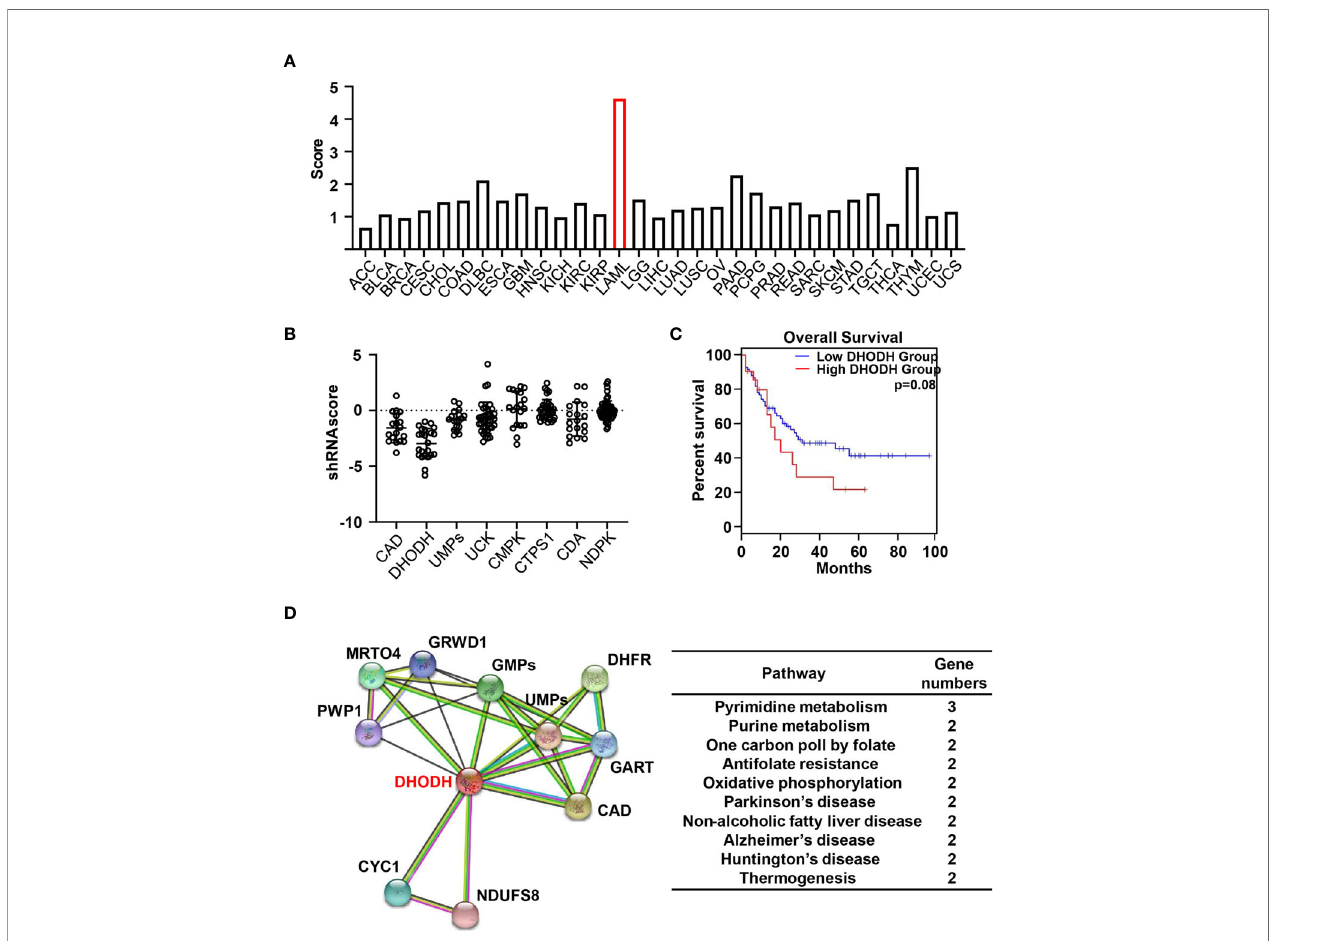
FIGURE 4 | Bioinformatics analysis of pyrimidine metabolism pathway (A) Histogram indicate the score of protein abundance of multiple key enzymes involved in pyrimidine metabolism pathway in 31 TCGA tumor tissues compared with corresponding normal tissues in GEPIA. The gene set includes CAD, DHODH, UMPs, UCK1, CMPK, NDPK, CTPS, SLC28A1, SLC28A2, SLC28A3, SLC29A1, SLC29A2, SLC29A3, SLC29A4. (B) Dot plots demonstrate the shRNA scores in AML cell lines in CCLE targeting multiple key enzymes involved in pyrimidine metabolism pathway. (C) Survival plots suggest the disease-free survival (DFS) for the low and high expression groups of DHODH among AML patients with median cutoff in GEPIA database. (D) Predicted the proteins interacted with DHODH according to the STRING V11.0 software and clustered these enzymes through KEGG